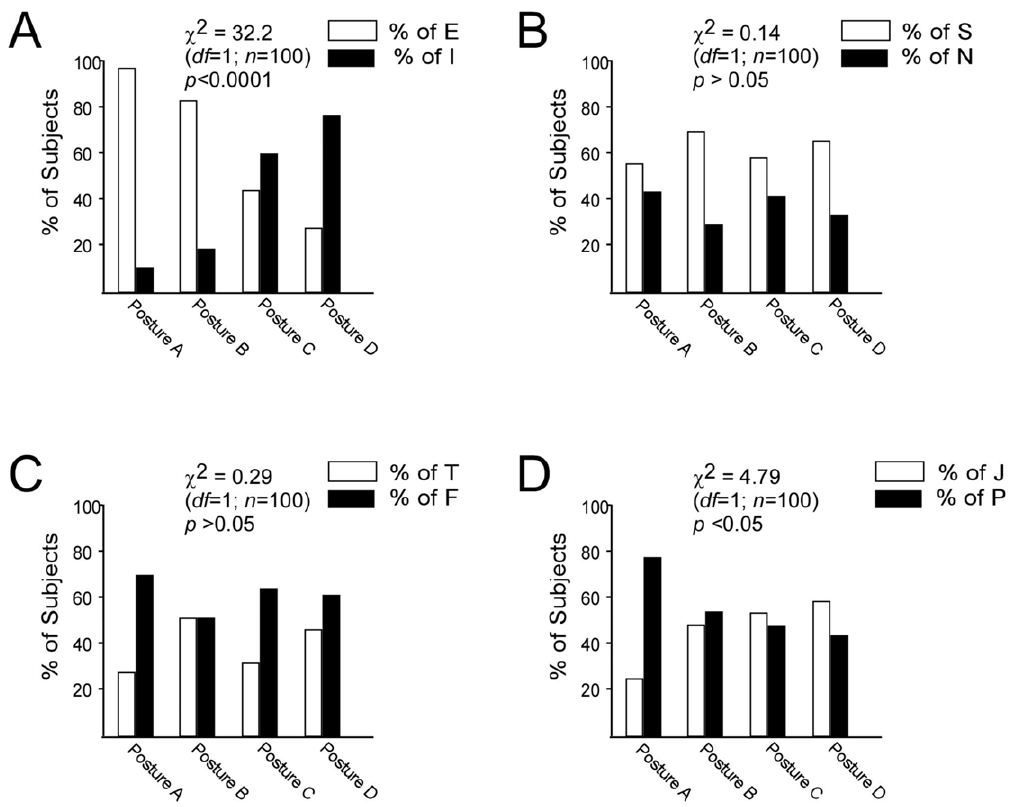
Figure 2. Correlation of personality types and the four different posture types. In ideal posture (A), there were 96% of Extraverted subjects, kyphosis-lordosis posture (B) had 83% of Extraverted preference, flat back posture (C) had 42% and sway-back posture (D) had 26% ( A ). Percentage of Sensing and Intuitive Preferences did not differ by posture category ( B ). There was no significant relationship between Thinking (T) and Feeling (F) preferences, and posture ( C ). However, Judging (J) or Perceiving (P) preferences significantly varied with the posture types ( D ).